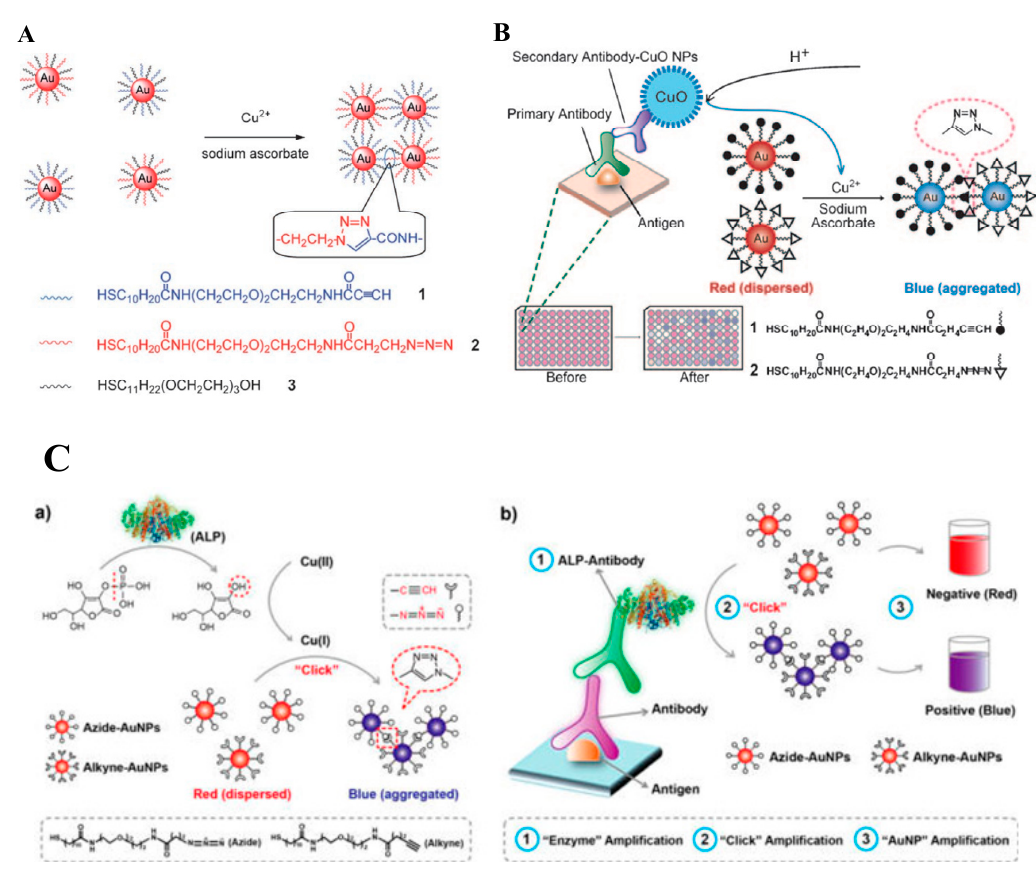
Figure 11. ( A ) The detection of Cu 2+ ions using click chemistry between two types of gold NPs, each modified with thiols terminated in an alkyne (1) or an azide (2) functional group. Reproduced with permission from [121]. Copyright John Wiley and Sons, 2008. ( B ) Copper-mediated amplification allows a readout of the immunoassay by the naked eye based on CuO-labeled antibody and click chemistry. Reproduced with permission from [122]. Copyright John Wiley and Sons, 2011. ( C ) Plasmonic nanosensor based on ALP-triggered CuAAC between azide- and alkyne-functionalized AuNPs and a naked-eye readout of plasmonic immunoassays based on ALP-triggered CuAAC through three-round amplification. Reproduced with permission from [123]. Copyright American Chemical Society, 2014.